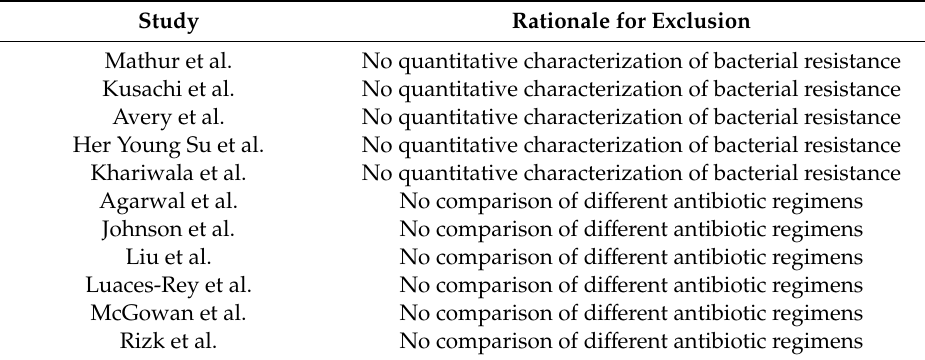
Table 3. Table showing references of excluded studies after full text evaluation with rationale for